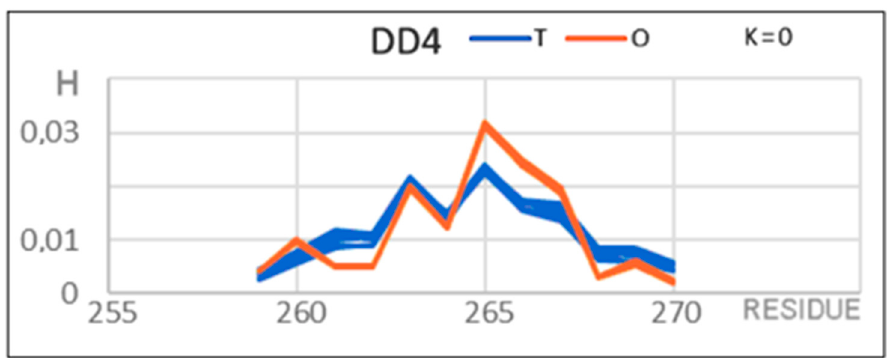
Figure 5. Set of T and O profiles for the DD4 domain in HpMscS. There is a clear high agreement of the idealized (T) and observed (O) distribution. The determined value of K = 0 does not require the determination of the M distribution.